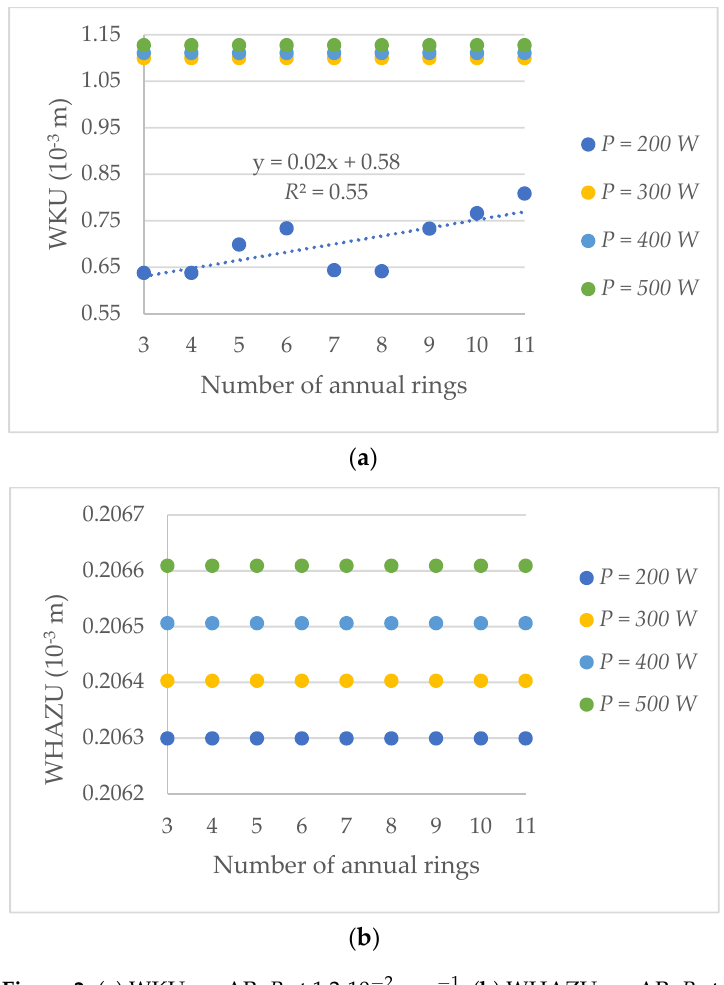
Figure 2. ( a ) WKU vs. AR, P at 1.2·10 − 2 m·s − 1 ; ( b ) WHAZU vs. AR, P at 1.2·10 − 2 m·s − 1 . From Figure 2b is good to see that laser power don’t have significant effect on WHAZU